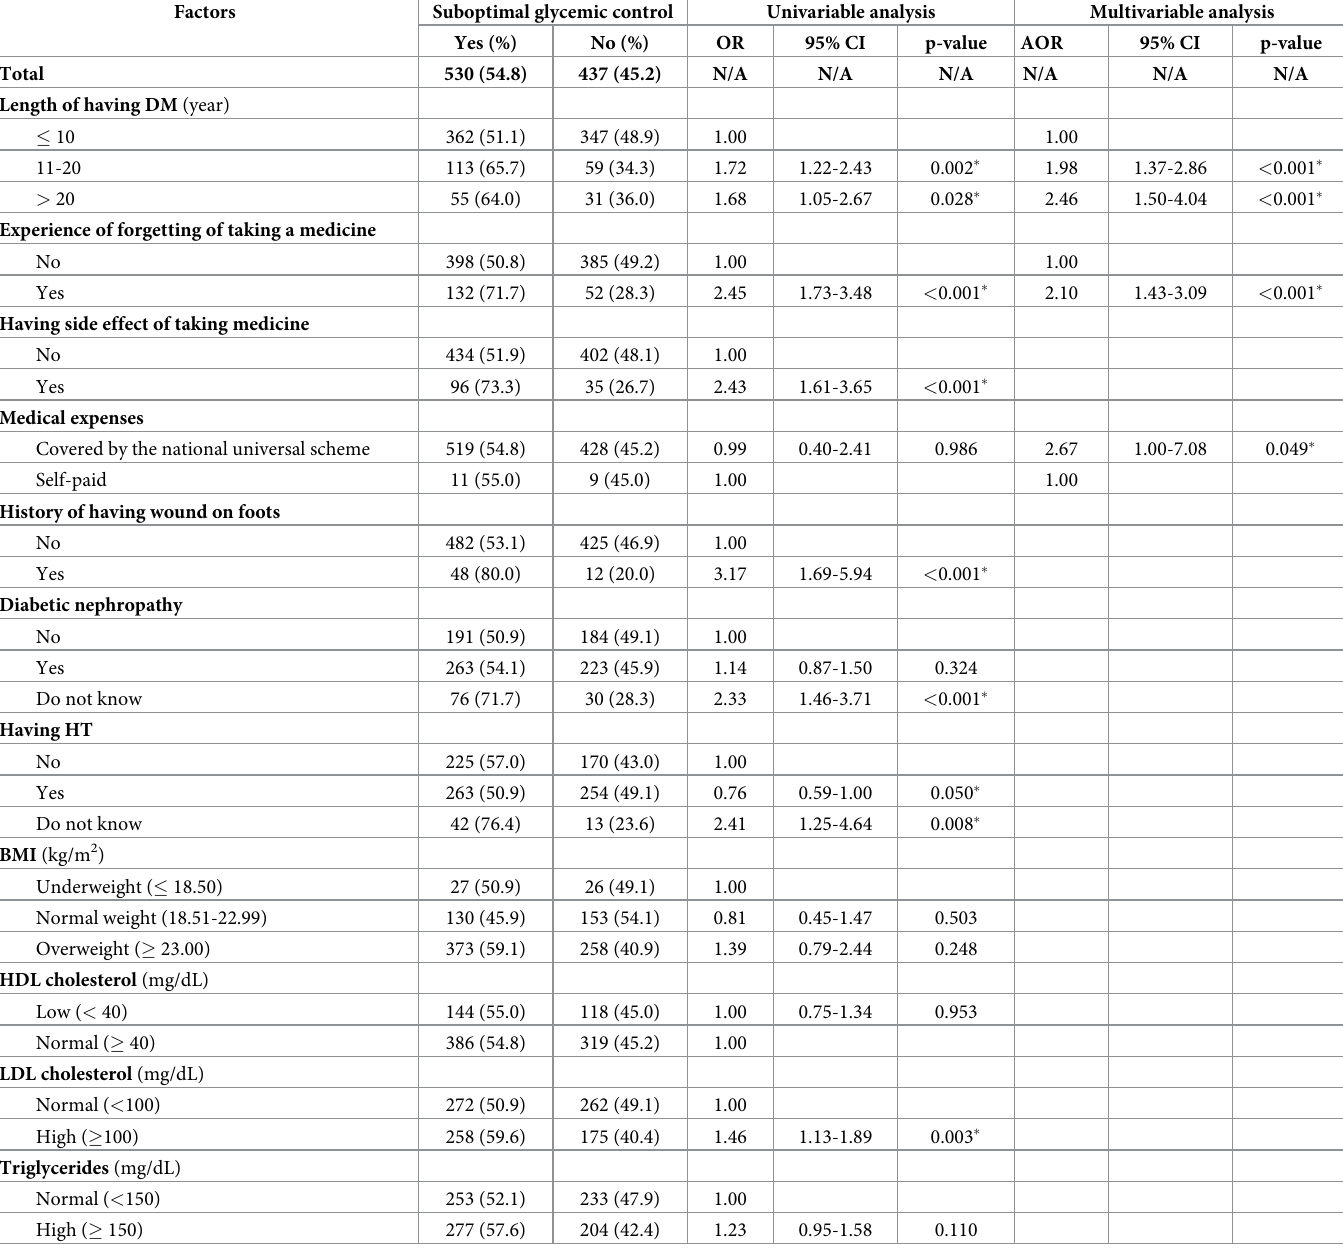
Table 6. Identifying medication and biochemical markers associated with suboptimal glycemic control among DM patients by univariable and multivariable logis- tic regressions. Factors Suboptimal glycemic